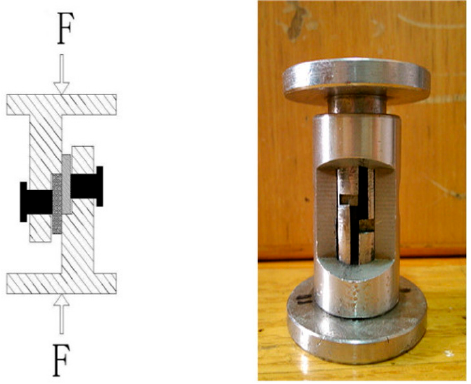
Figure 3. Schematic diagram of the shear test fixture and picture of the object.